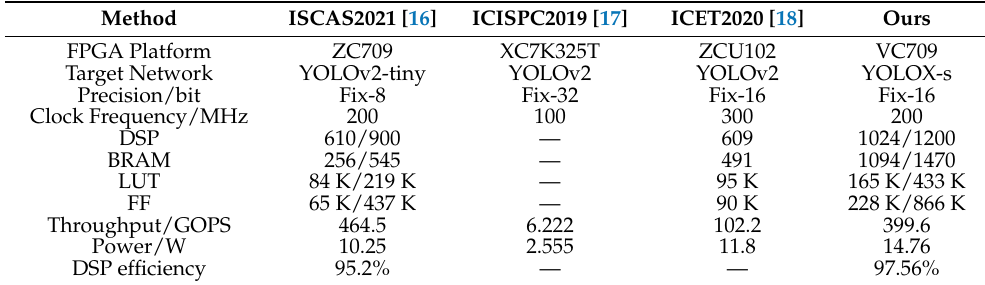
Table 3. Comparison of different YOLO implementations on